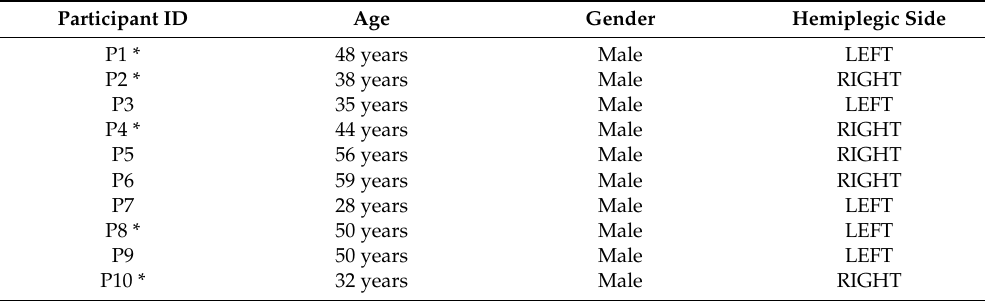
Table 1. Ten chronic ( > 6 months) stroke participants.